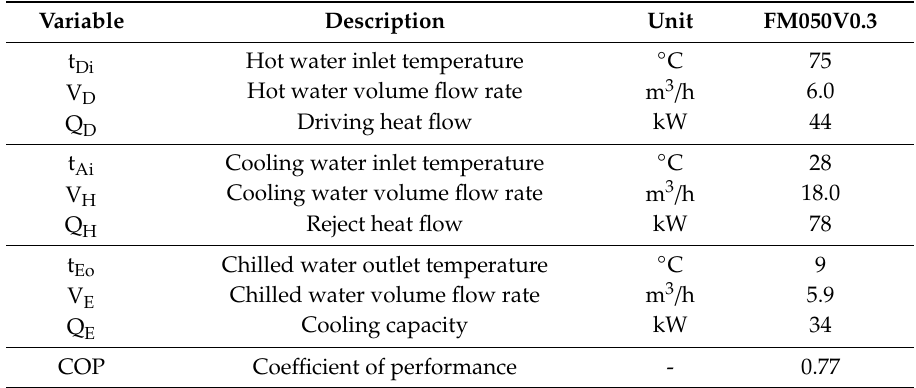
Table 1. Design values of the absorption chiller type FM050V0.3 at the Federal Environment Agency (UBA) in Dessau, Germany.